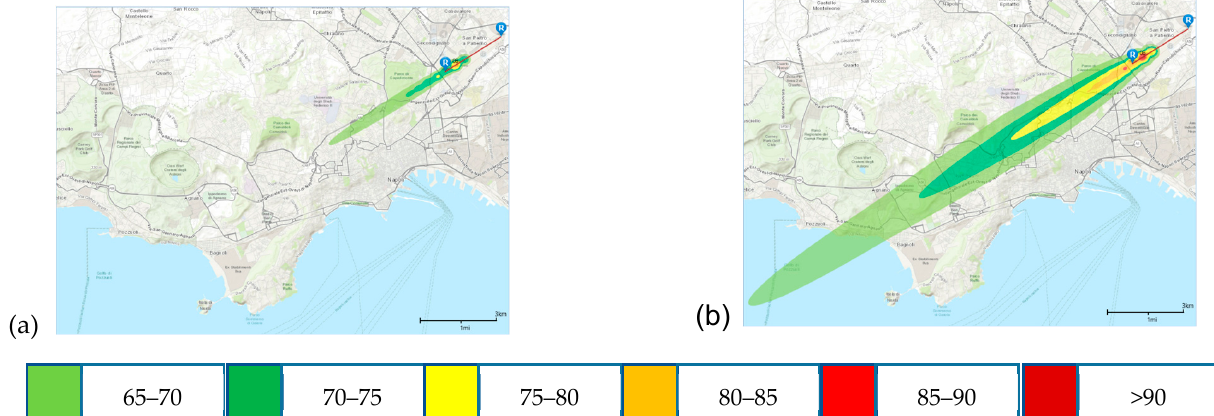
Figure 42. Graphical representation of equal loudness contours for the conventional ( a ) and hybrid ( b ) configurations, in terms of L AE (dB-A), for a standard runway-06 landing.